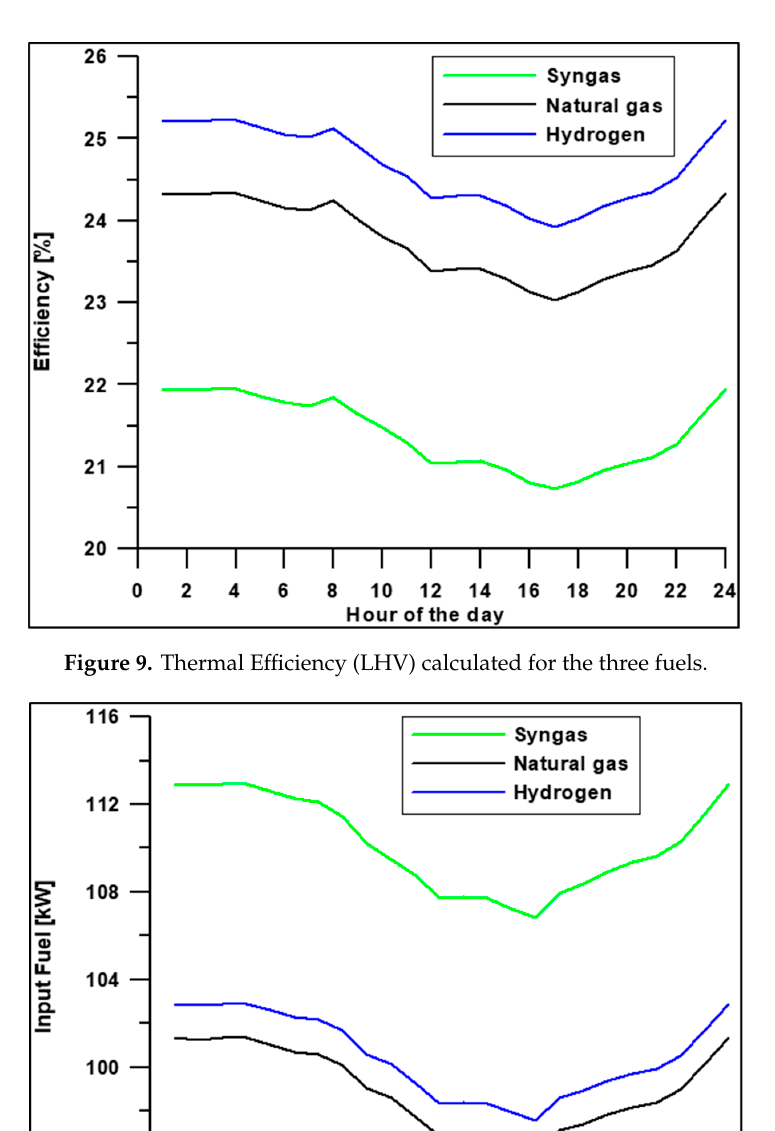
Figure 11. Heat transfer in heat recovery unit in a day. In view of the opposite trends achieved by syngas and hydrogen fuels for net power output and Heat Transfer to the HRU figures of merit, a thorough cogeneration and exergy analysis on heat exchanger #8, shown in Figure 1, were considered fundamental to assess the overall performance. Cogeneration and exergy analysis are presented in Sections 3.3 and 3.4, respectively. In a second step, the fuel comparison was extended to the whole year by varying irradiance and ambient temperature and the day-averaged results are presented on a month-to-month basis in Figures 12–17. It is worth mentioning that results presented in Figures 12–14 (i.e., power, thermal efficiency (LHV) and heat transferred to the HRU for the three fuels) are averaged on daylight hours